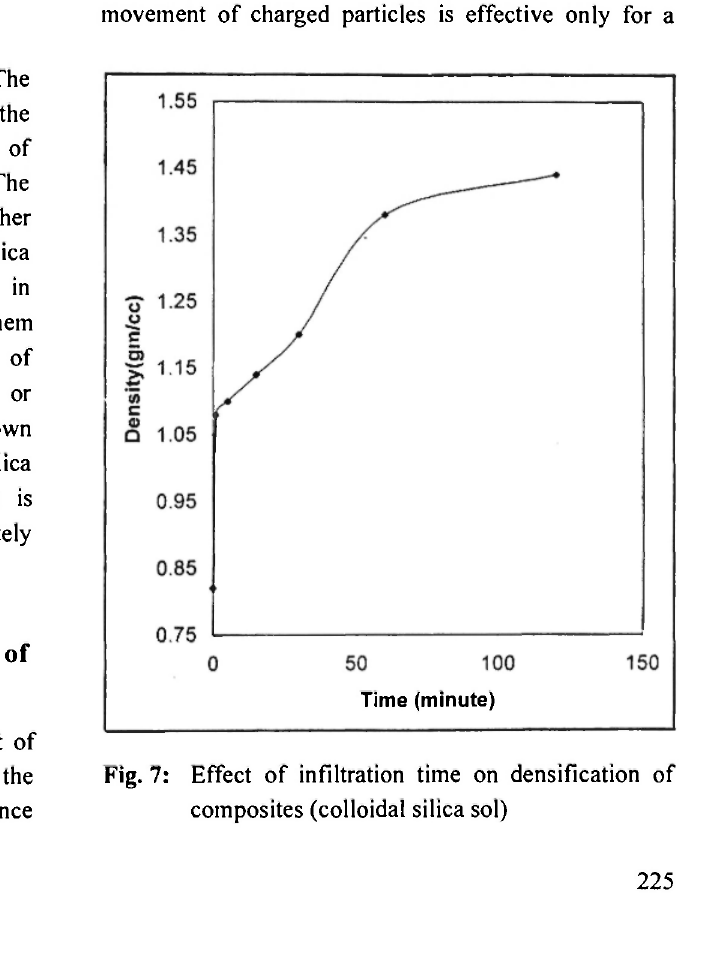
Fig. 6: Effect of applied voltage on density of composites with number of infiltrations